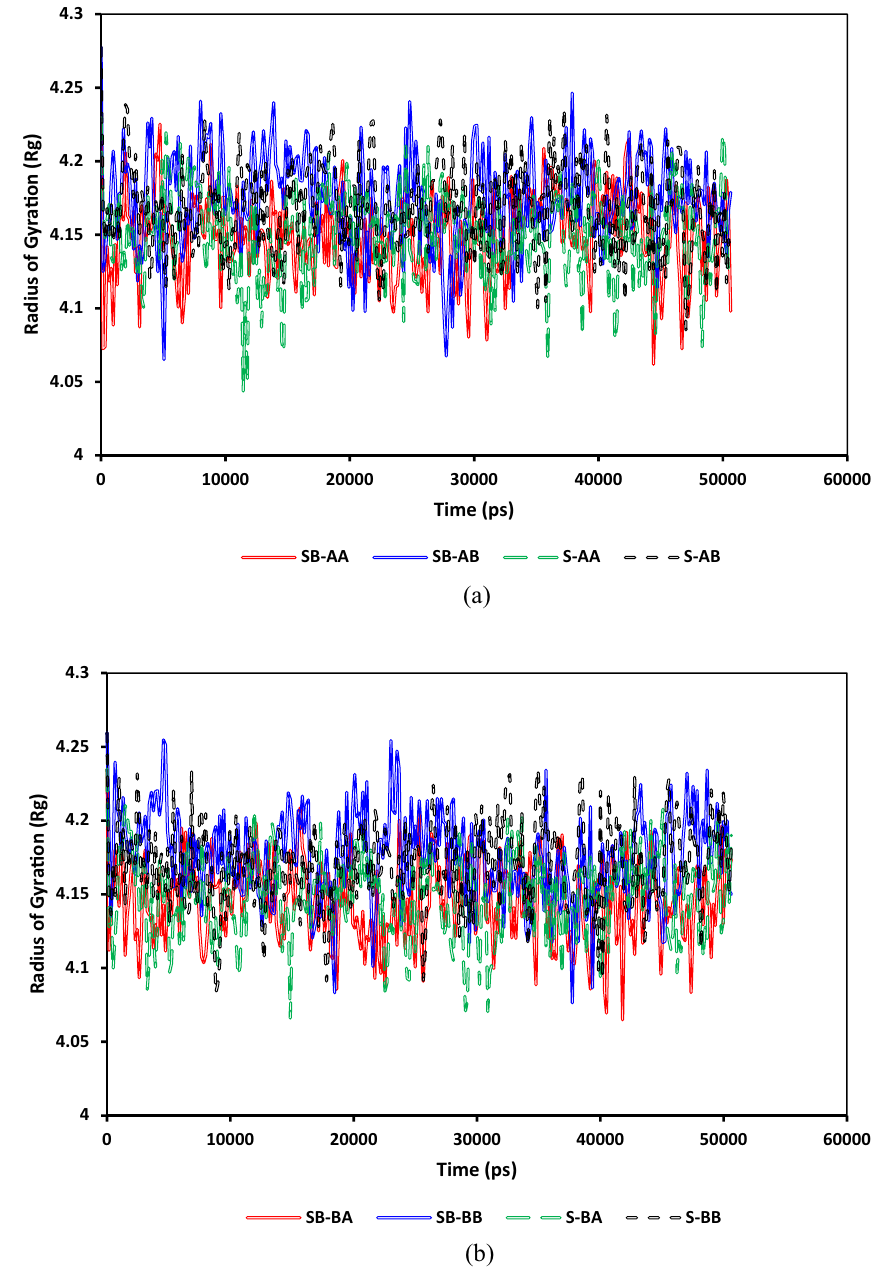
Figure 13. Comparison between the radius of gyration of resin for systems containing ( a ) C 40 H 30 O 2 and ( b ) C 44 H 40 N 2